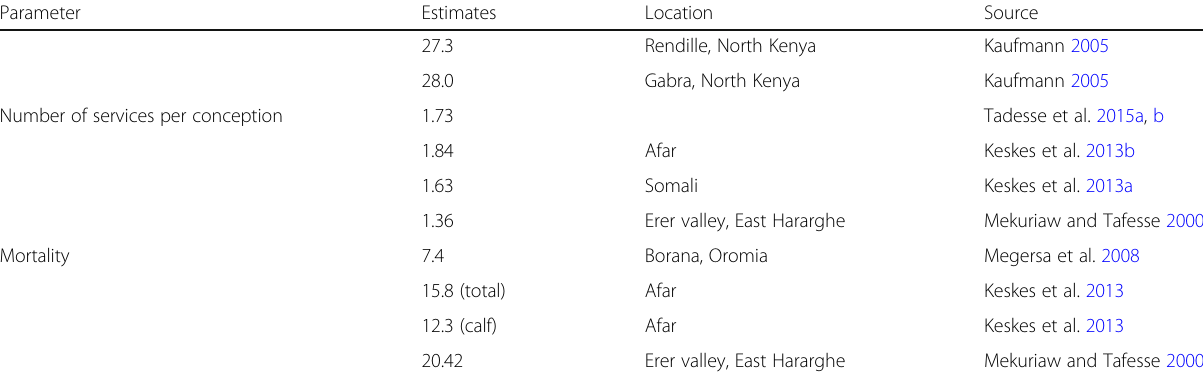
Table 4 Estimates of reproductive performance of camels in different areas of Ethiopia (Continued)